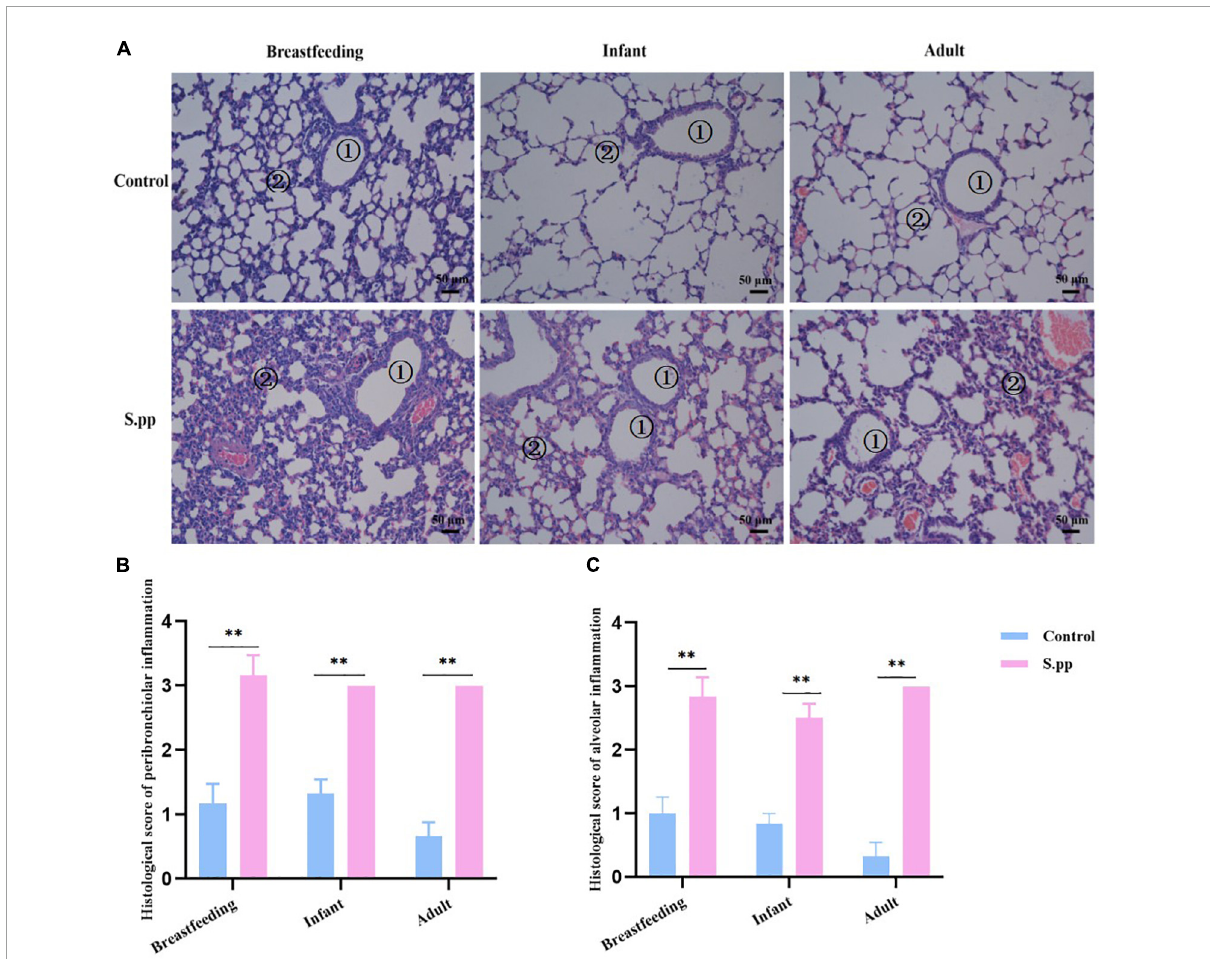
FIGURE2 Neonatal S. pneumoniae infection induces inflammatory cell infiltration in lung tissues at different stages. (A) Representative H&E staining in lung slices from mice in the control and S. pp groups during the breastfeeding period, infancy, and adulthood (200 × magnification). The numbers in the figures indicate bronchioles (cid:192) , alveoli (cid:193) . (B) Histological scores of pulmonary peribronchiolar inflammation. (C) Histological scores of pulmonary alveolar inflammation. n = 3–6 mice/group. ** P < 0 . 01, compared with control